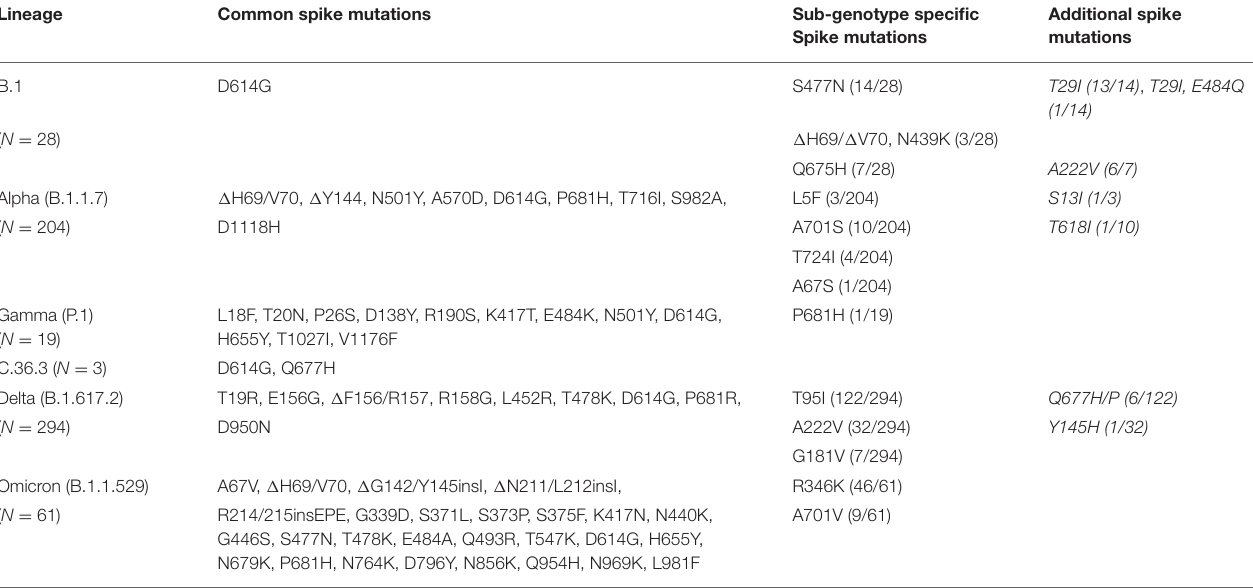
TABLE 2 | Mutations identified in VOCs from March 2021 to February